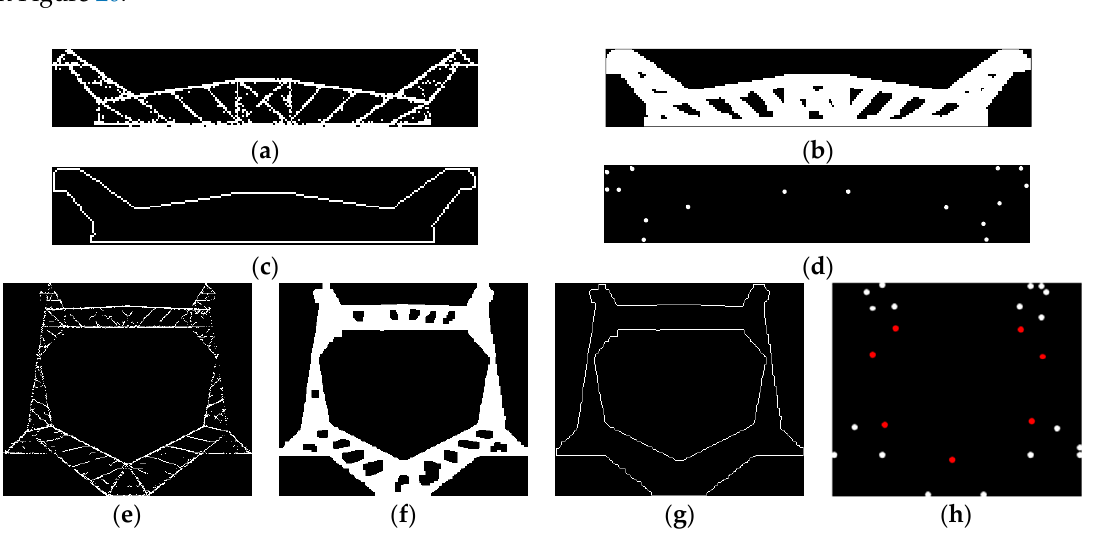
Figure 20. Extracting corner points: ( a,e ) the result of binarization; ( b,f ) the result of morphological operation; ( c,g ) the result of actual contour extraction; ( d,h ) the result of corner points extraction. Optimization